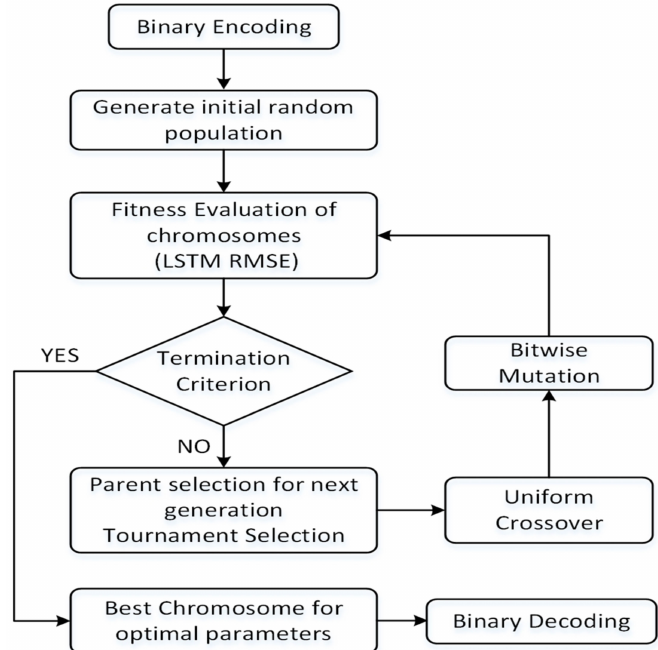
Figure 2. Tailored genetic algorithm (GA) for LSTM model optimization.